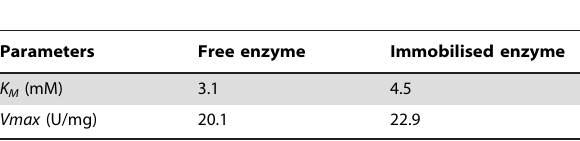
Table 3. Kinetics of free and immobilised lipase using p-NP palmitate as